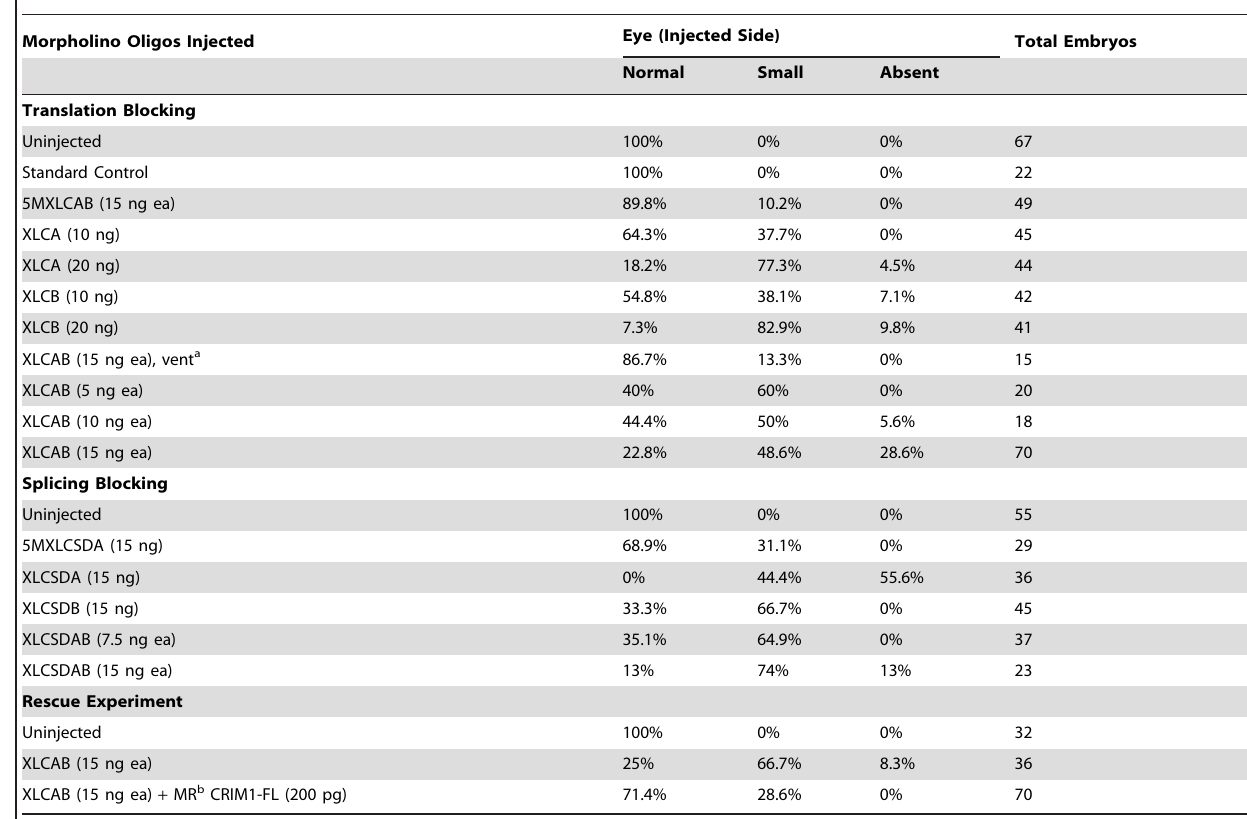
a : ventral blastmeres instead of dorsal blastmeres were injected with morpholino oligos. b : MR means morpholino oligonucleotide resistant.